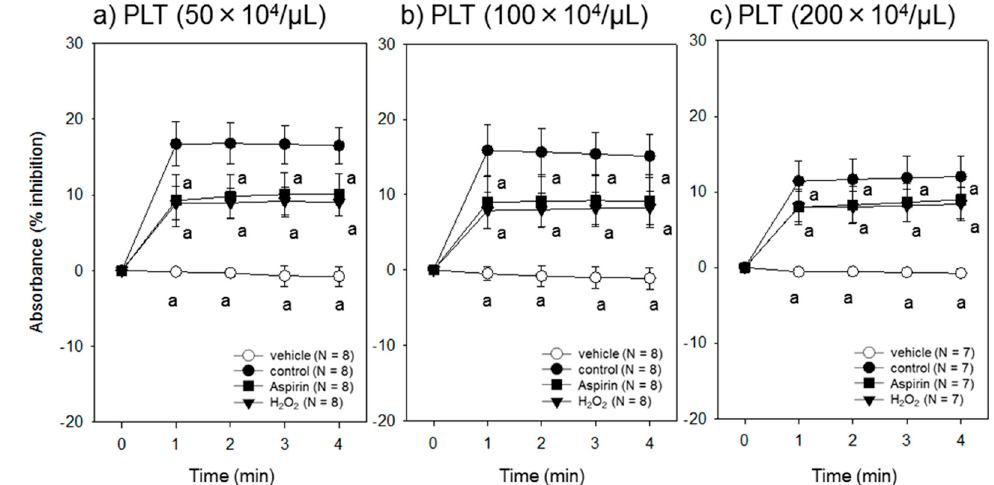
Figure 4. E ff ect of platelet densities on ADP-induced aggregation of dysfunctional platelets over a time course. Platelets were treated with a vehicle of aspirin (0.1% dimethyl sulfoxide), aspirin or H 2 O 2 , resuspended in PBS at a density of ( a ) 50 × 10 4 / µ L, ( b ) 100 × 10 4 / µ L or ( c ) 200 × 10 4 / µ L and stimulated with 5 µ M ADP for up to 4 min at ambient temperature. a p < 0.05 compared with the corresponding controls at the same time points.